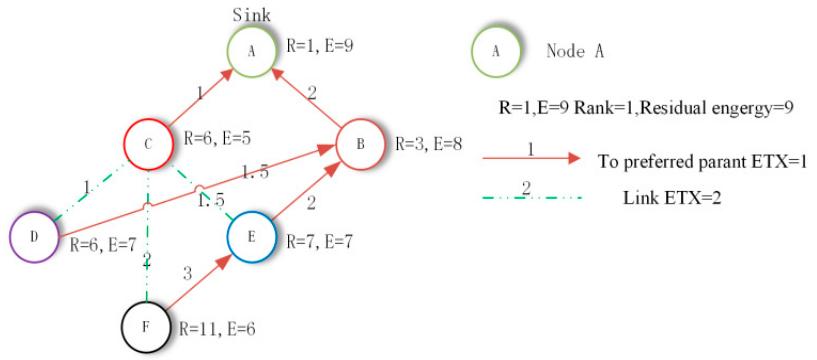
Figure 2. Network topology constructed according to the residual energy.